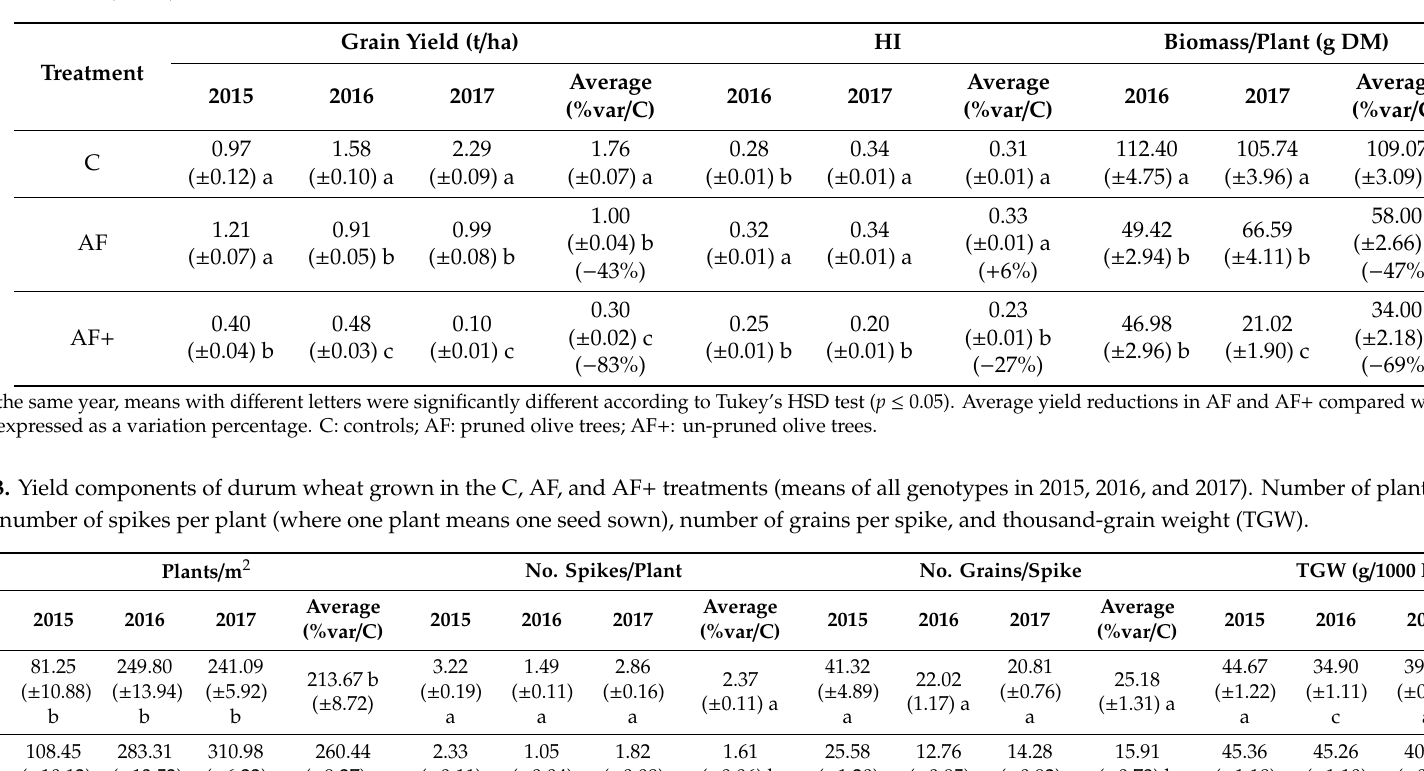
Table 2. Yield, harvest index (HI), and biomass / plant (g of dry matter (DM); at harvest, including grain) of durum wheat (average of 25 varieties, ± SE) in three treatments in 2015, 2016, and 2017.